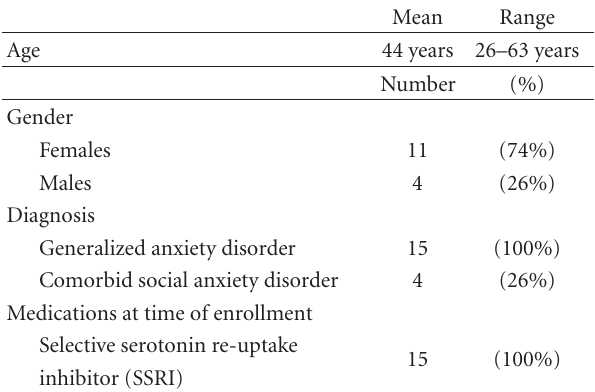
Table 1: Demographic and clinical characteristics of